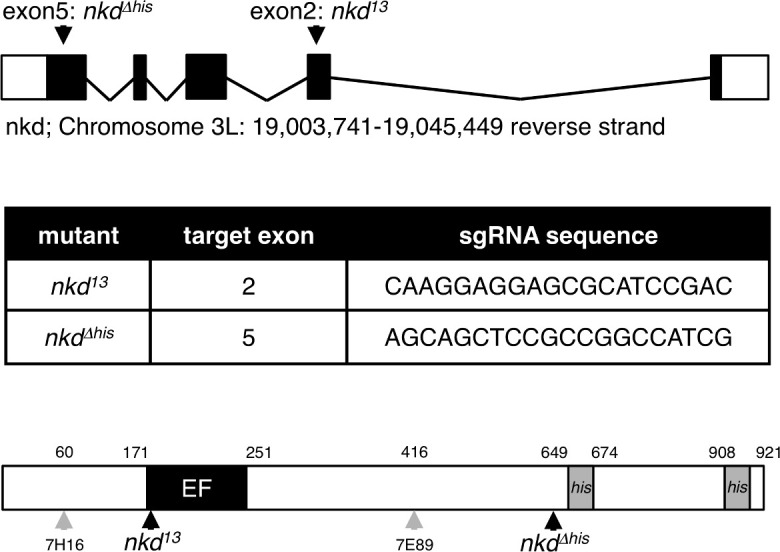
CRISPR-engineered Drosophila nkd alleles.Top, genomic location and organization of the Drosophila nkd locus, with positions of CRISPR gRNAs indicated; underneath, sequences of gRNAs used for generating two different nkd truncations, each verified by sequencing; bottom, cartoon of Naked, with domains and positions of various alleles indicated.